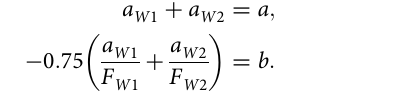
Table 1 The values of the parameters for the calculation of the magnetostriction Δ L / L along the c axis at B ∥ c in neglect of the B dependence of ζ .